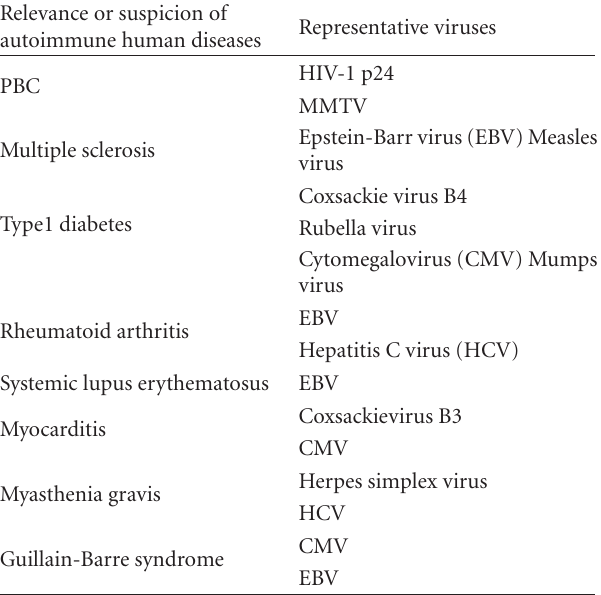
Table 1: Viral infections in humans associated with autoimmune